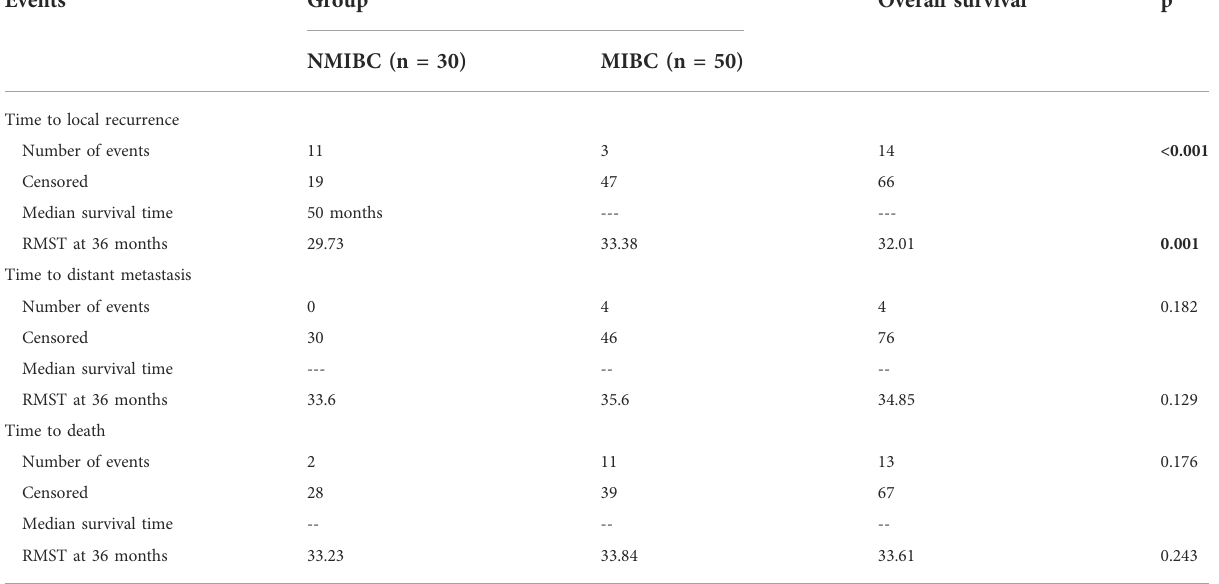
TABLE 8 Survival analysis of cancer patients after 60 months follow up: Events